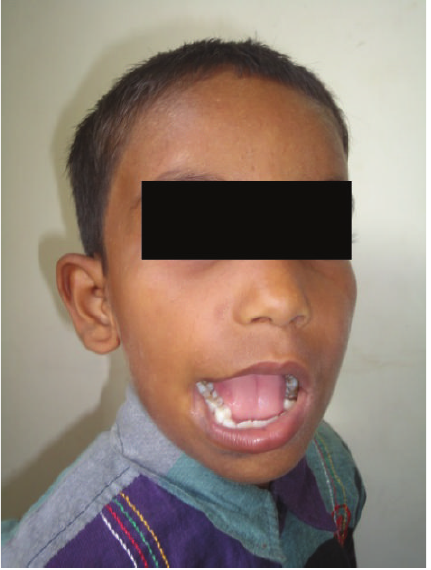
Figure 1: Preoperative photograph with right side ill-formed com- missure.